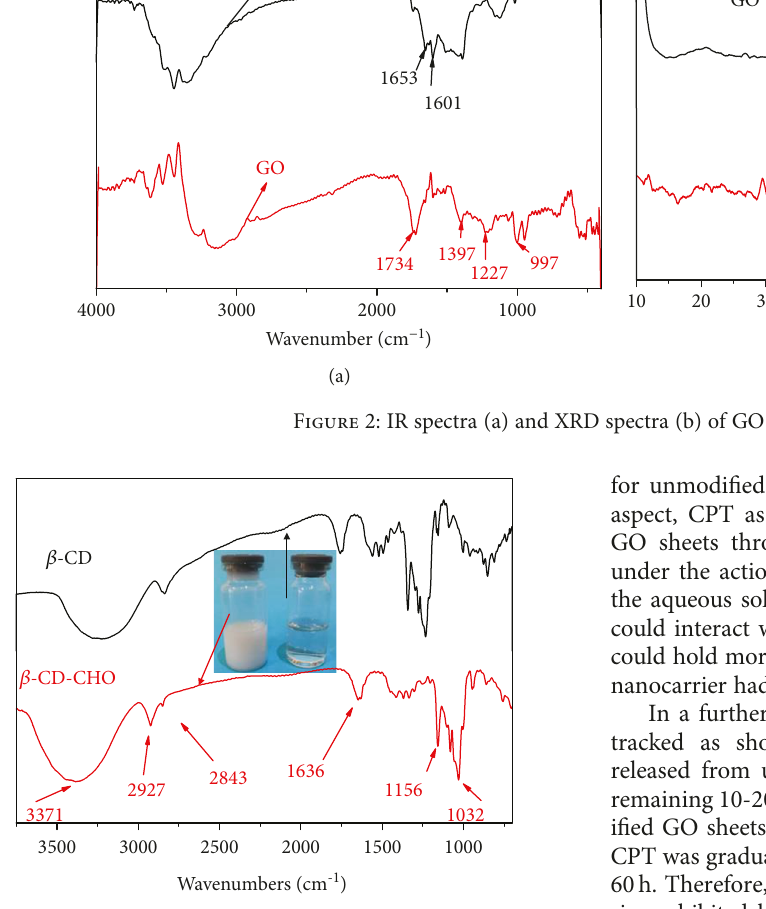
Figure 3: IR spectra of β -CD and β